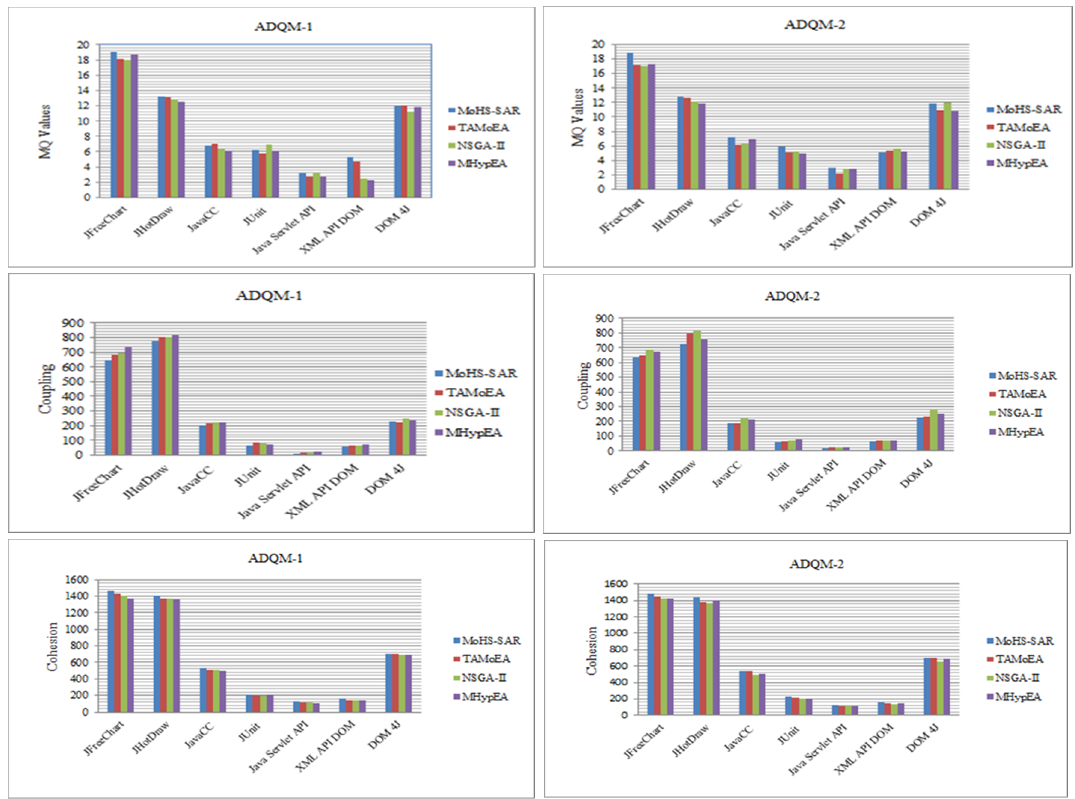
Figure 2. Comparison of algorithms in terms of MQ, coupling, and cohesion.